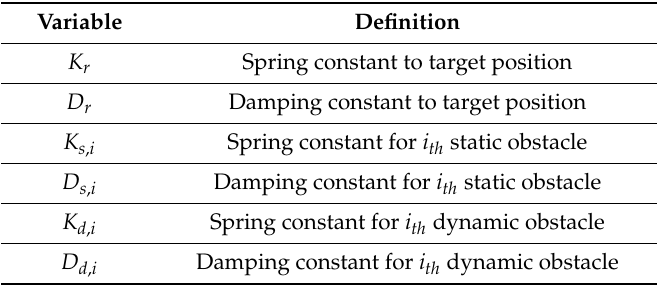
Table 3. Constants for virtual impedance